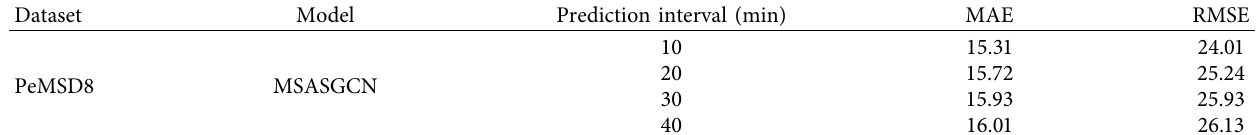
Table 4: Average performance of experiments with different prediction intervals on PeMSD8.